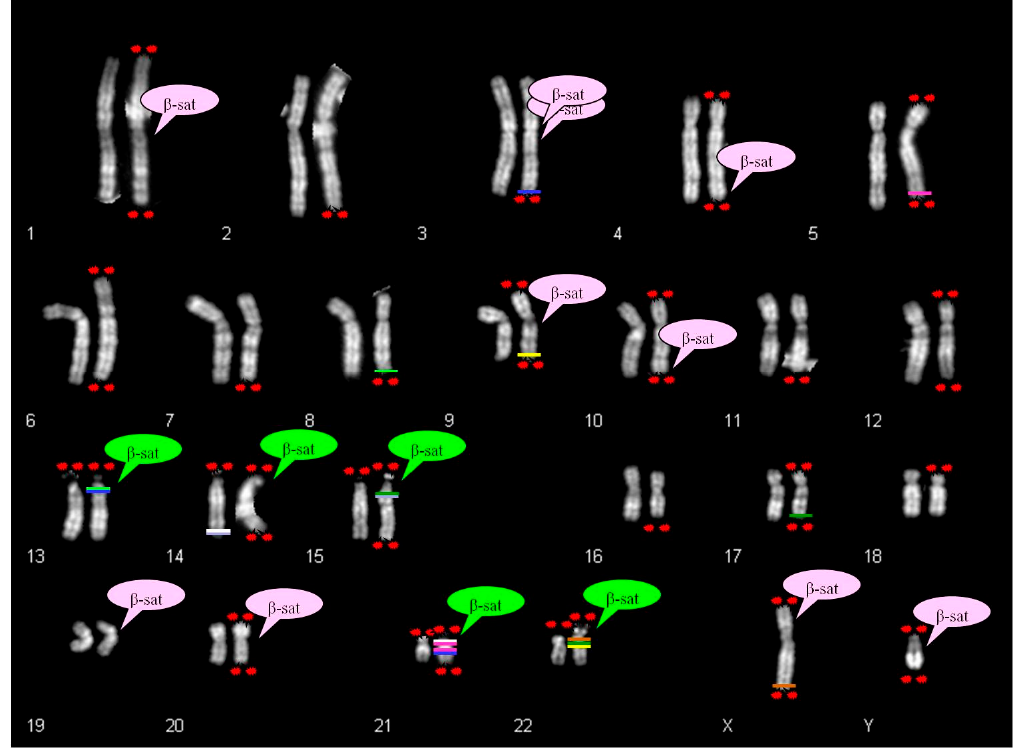
Figure 8. β -Satellite clusters DNA mapping [27–29] in a human normal male karyotype. Red spot: satellites on the short and long arms of chromosomes; for non-acrocentric chromosomes satellites are collected by literature or our cases. Green cloud: canonical beta-satellite sequences on acrocentric chromosomes; pink cloud: interspersed beta-satellite sequences on non-acrocentric chromosomes. Colored lines indicate homologous segmental duplications between telomeric regions of non-acrocentric chromosomes (except for 14qs case) and p-arms of acrocentric chromosomes; homologous tracts are shown with a line of the same color and precisely: 3q29 homologous with 13q12.11 and 21q11.2 (blue line); 5q35.3 homologous with 21p11.1 and 21q11.2 (fuchsia line); 8q24.3 homologous with 13q12.11 (fluorescent green line); 9q34.3 homologous with 22q11.21 (4 consecutive traits in the same cytogenetic band)(yellow line); 14q32.33 homologous with 15q11.1 and 15q11.2 (lilac line); 14q32.33 homologous with 21p11.2 (white line); 17q24.3 homologous with 15q11.2 and 22q11.21 (dark green line); Xq28 homologous with 22q11.1 (light brown line).